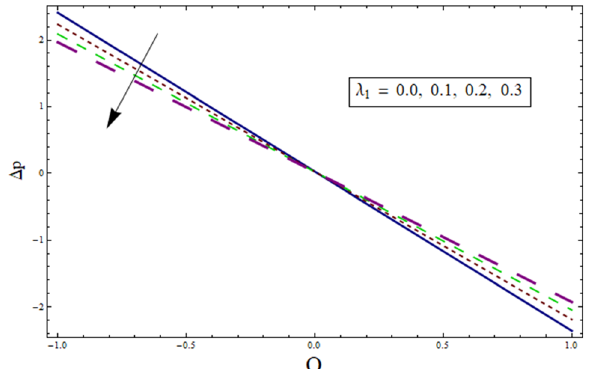
Figure 23. Δp for (cid:31) 1 .